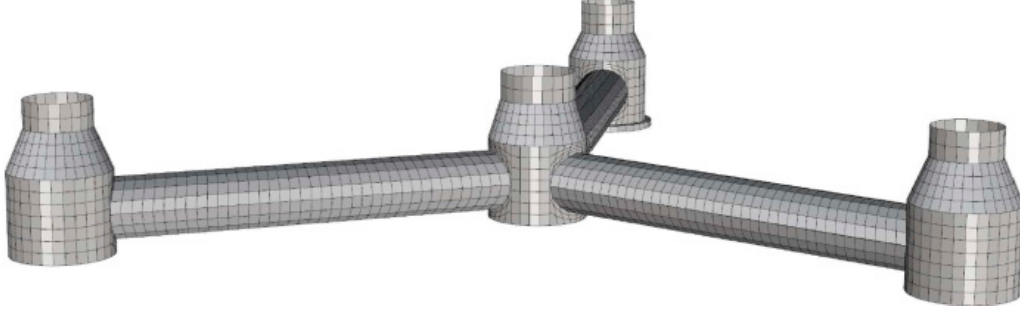
Figure 8. Low-order mesh considered in the WAMIT code analysis.